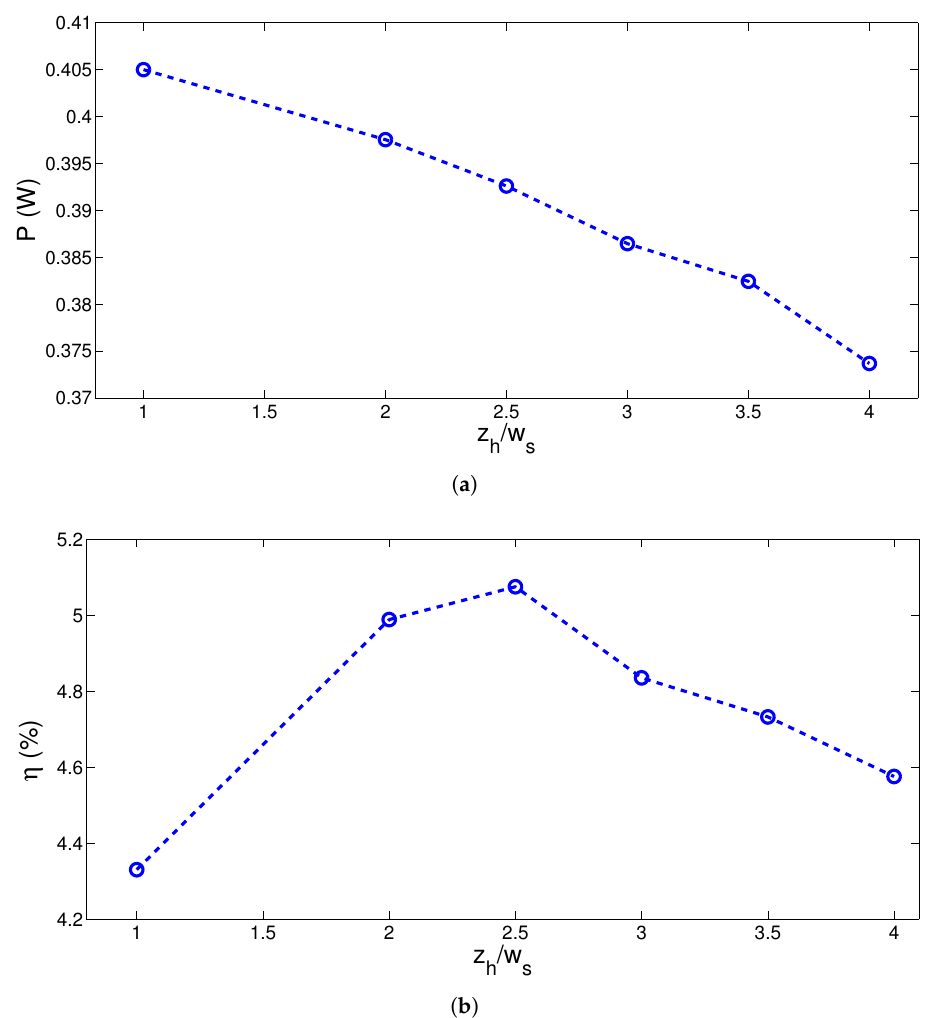
Figure 13. Generated power ( a ) and efficiency ( b ) of the TEG module with varying distance from the inlet to target surface ((Re 1 , Re 2 ) = (500, 500), (r 1 , r 2 ) = (1,1), φ = 0.02). Nanojet is formed by using highly conductive CNT particles in the water jet consid- ering different solid volume fractions of particles. Thermal transport features are greatly enhanced which the inclusion of nanoparticles. Variation of hot and cold side interface temperatures with varying solid volume fraction of the particles are shown in Figure 14 ((Re 1 , Re 2 ) = (500, 500), (r 1 , r 2 ) = (1, 1), z h = 3w s ). The cold side temperature dropped and hot side temperature rose throughout the TEG interface surface with higher φ . Generated power and efficiency versus varying solid volume fraction showed a linear increasing trend for different (r 1 , r 2 ) combinations (Figure 15). As compared to using a pure water jet, power enhancements were in the range of 12% and 14% with nanojet at the highest particle volume fraction. Highest efficiency of 4.87% was achieved at r 1 = 1.5 with nanojet at the highest φ while the increment in the efficiency was only 3.5% as compared to the water